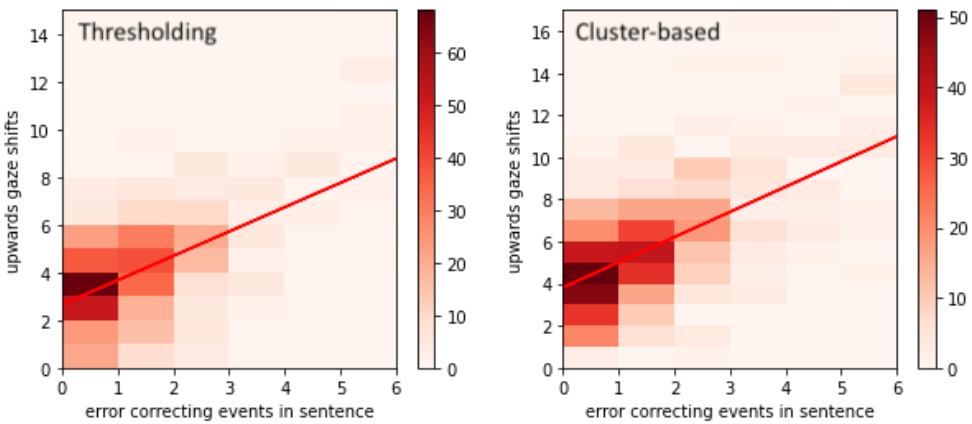
Figure 13. 2D histogram and regression lines showing the correlation between the number of errors and gaze shifts ina